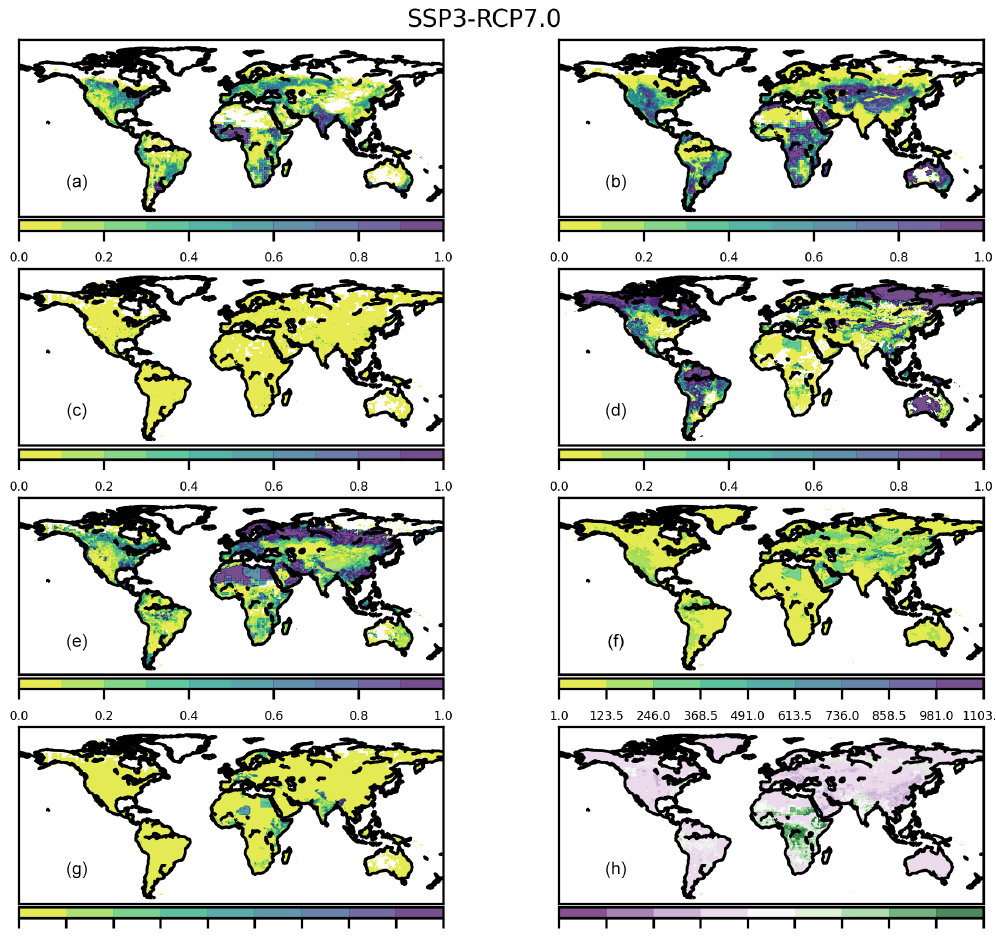
Figure 12. Maps for the year 2100 for the SSP3-RCP7.0 scenario showing the following: (a) the fraction of each grid cell occupied by cropland; (b) the fraction of each grid cell occupied by pasture; (c) the fraction of each grid cell occupied by urban land; (d) the fraction of each grid cell occupied by primary vegetation; (e) the fraction of each grid cell occupied by secondary vegetation; (f) the mean age (in years) of secondary lands in each half-degree grid cell; (g) the mean gross transitions (km 2 yr − 1 ) over a 20-year interval for each grid cell; and (h) the mean net transitions (km 2 yr − 1 ) over a 20-year interval for each grid